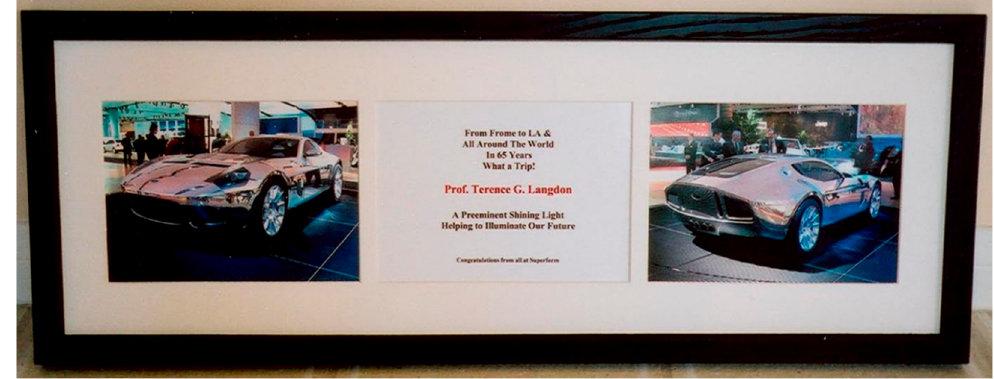
Figure 12. A plaque presented by Superform USA to one of the authors at a conference in San Francisco in 2005 [58].